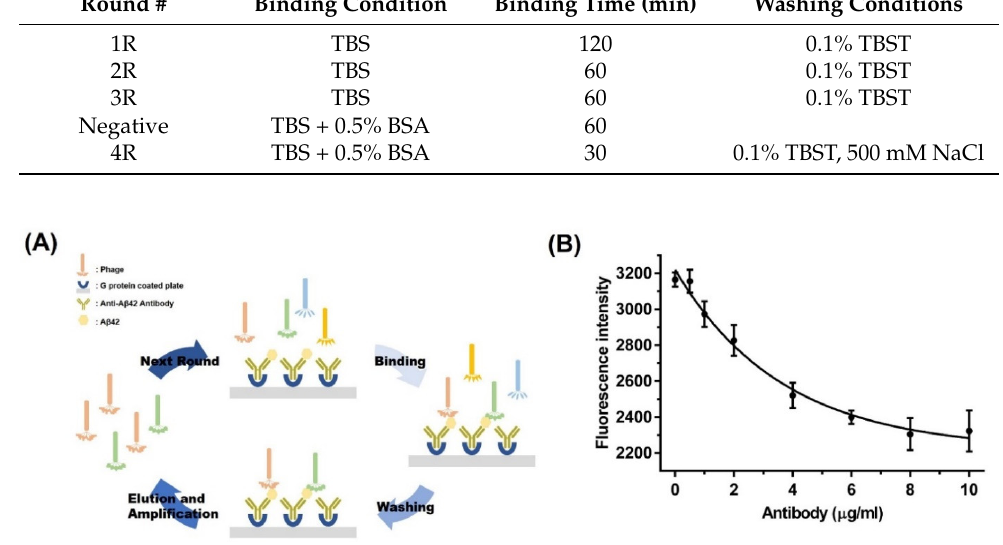
Figure 1. Scheme of biopanning and optimization of the screening conditions. ( A ) Most specific phages were screened via binding, washing, elution, and amplification steps, a procedure called biopanning. ( B ) The fluorescence signal from the FITC-labeled antibodies decreased as the concentration of anti-A β 42 antibodies increased. The test was performed in trip- licate under the same conditions.